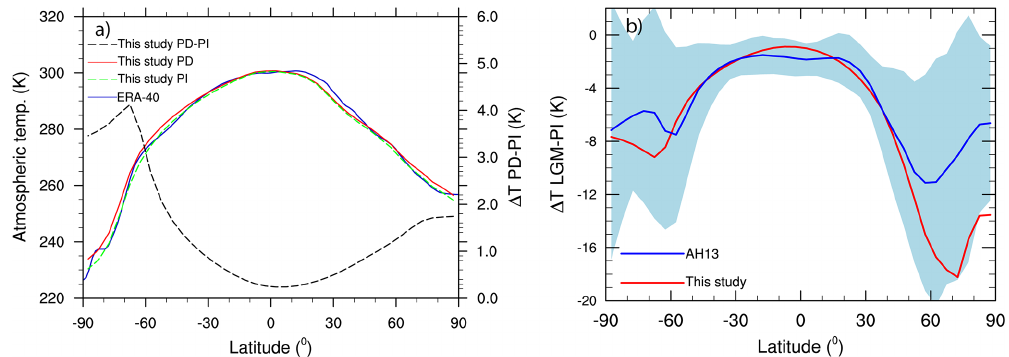
Figure 2. (a) Modelled PI (dashed green) and PD (red) atmospheric meridional temperature distributions and PD ERA-40 reanalysis data (Uppala et al., 2005, blue). (b) Modelled reference LGM–PI atmospheric temperature difference (red), compared to the data reconstruction of Annan and Hargreaves (2013) ([AH13]; blue, with error bars). Table 3. Values used for the data transfer from the ZEBCM to the ISM and vice versa. Note that in the ZEBCM, the East and West Antarctic ice sheets are combined into one. Ice sheet Area of temperature Location of centre Value of C vol input for ISM in ZEBCM Eurasian 40–80 ◦ N 65 ◦ N 0.92 North